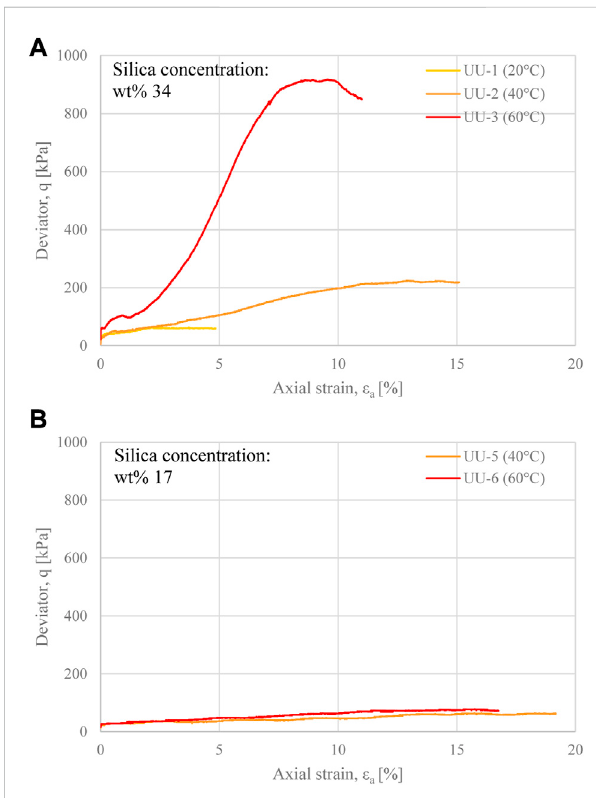
FIGURE 8 Deviator stress evolution with axial strain for grouted glass beads samples cured for 24 h at different temperatures, at silica concentration (A) wt% 34, and (B) wt% 17.